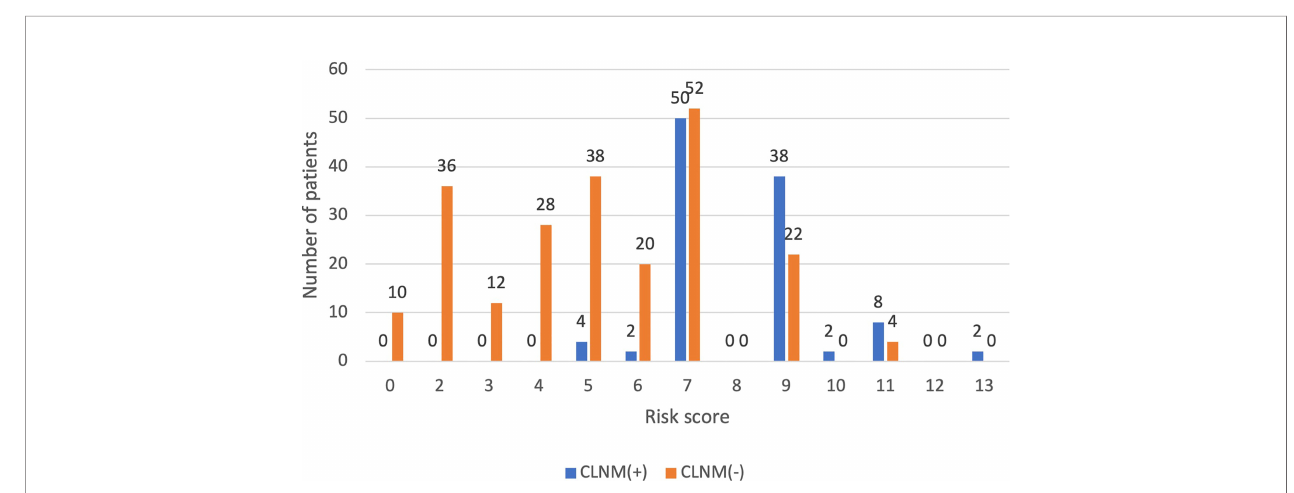
FIGURE 5 | The distribution of CLNM-negative and positive patients with different risk scores inthe validation group.